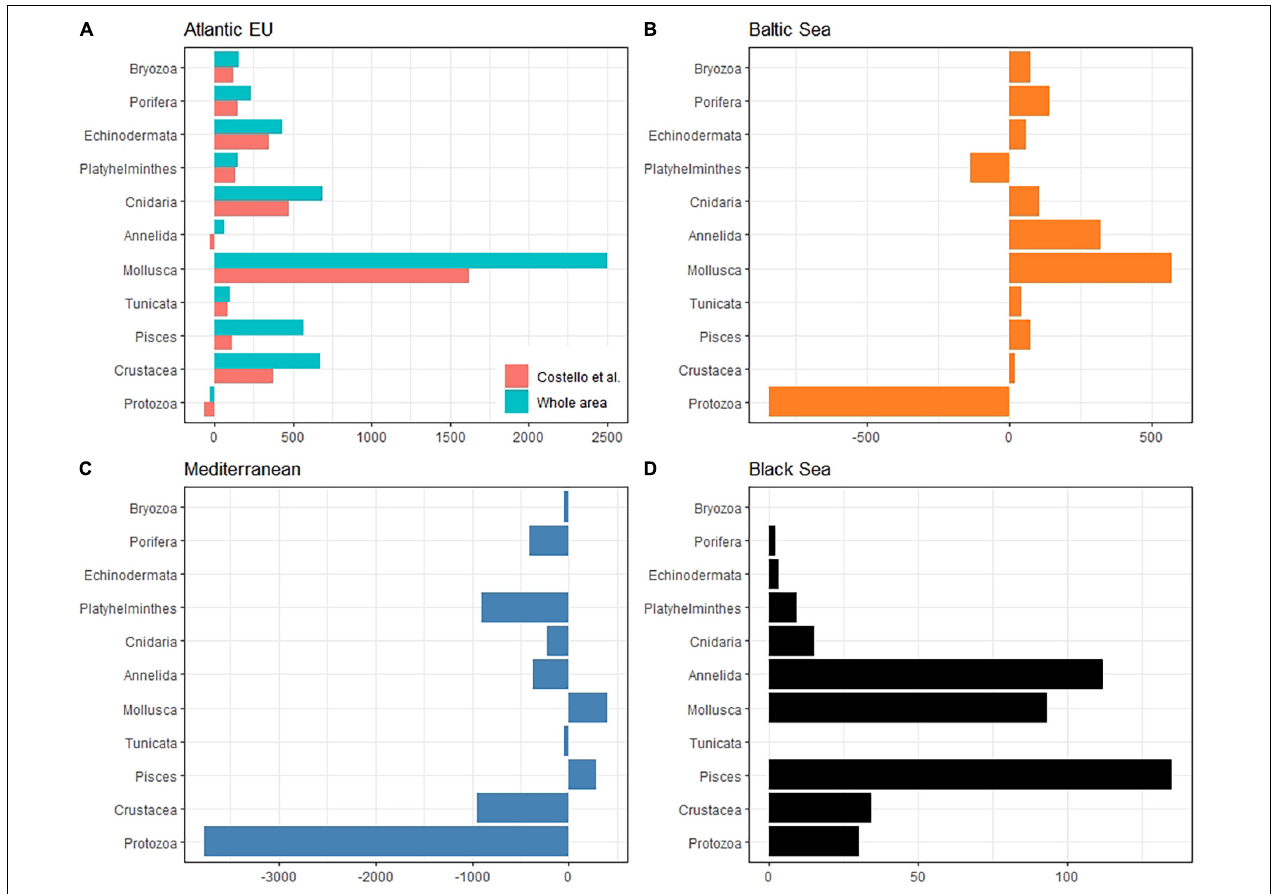
FIGURE 5 | Bar plot showing the difference between the total number of species per taxa reported in GBIF with respect to analogous results from Costello et al. (2010). Comparisons have been made for the Atlantic EU (A) , Mediterranean Sea (B) , Black Sea (C) , and Baltic Sea (D) . Positive values indicate a higher number of species reported in GBIF. What we consider here as Atlantic EU (whole area) differs from Costello et al. (2010) in that we also include marine waters around the Macaronesia (including Azores, Madeira, and Canary Islands), and the northernmost Atlantic waters (see Figure 1 ). For comparative purposes, we also consider the same Atlantic EU area as Costello et al. (2010). Note also that Costello et al. (2010) did not report biodiversity data for the Black